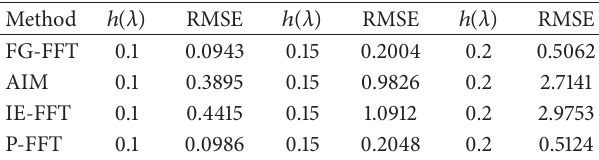
Figure 5: The dimensions of the hollow dielectric slab in Example B. Table 2: RMSEs of the RCSs in Example B.